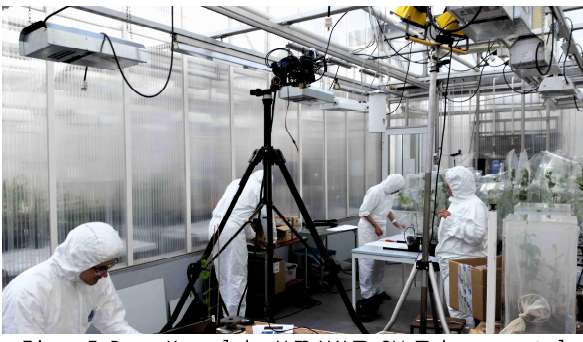
Figure 5 DroneKnowledge VIS-VNIR-SWIR hyperspectral imaging system on a camera mount used for spectral reflectance measurements of pea plants in the green house.